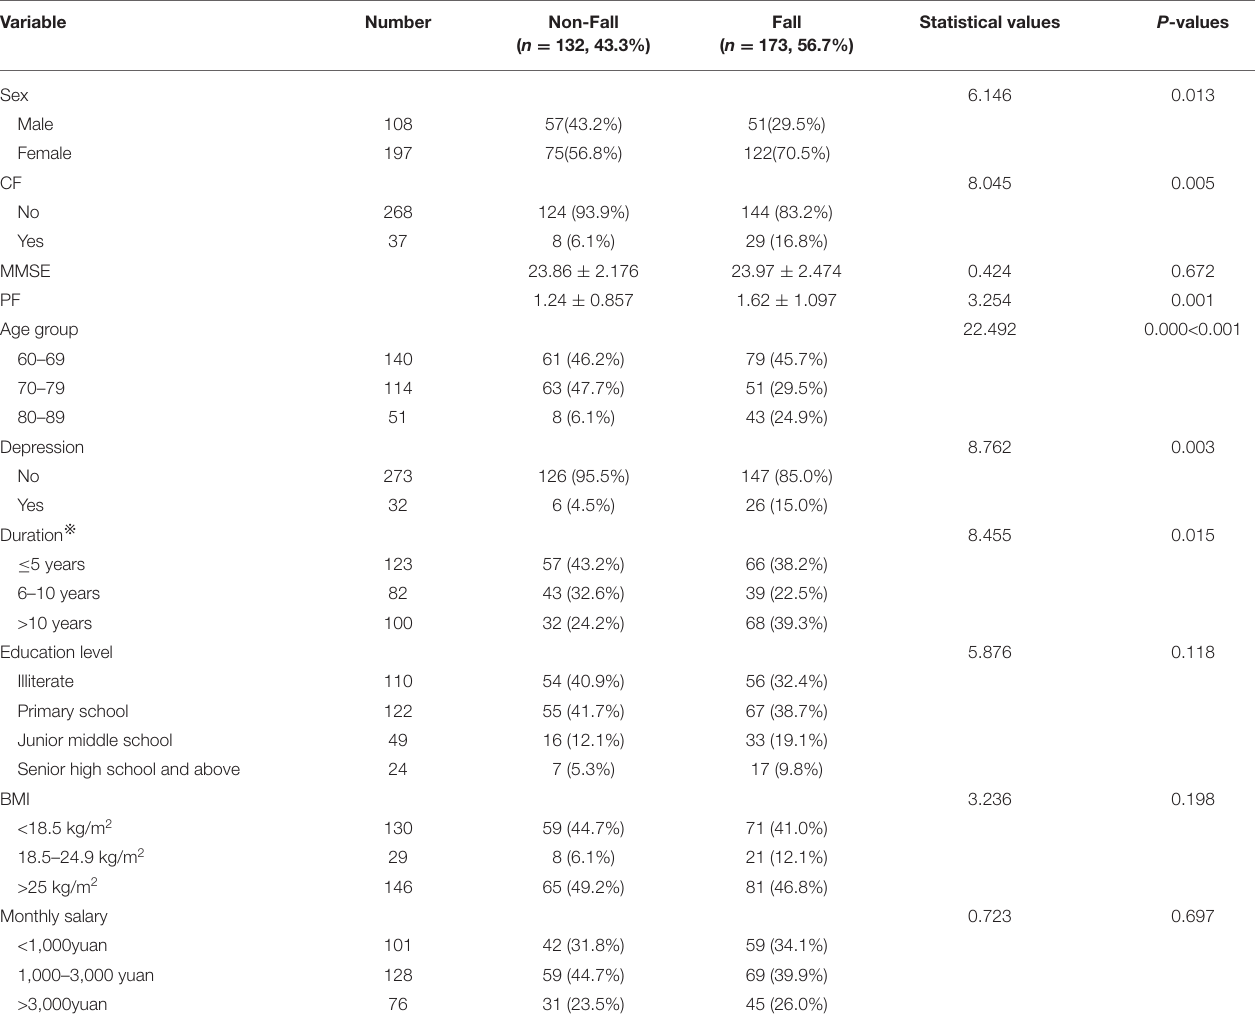
TABLE 1 | General demographic data and univariate